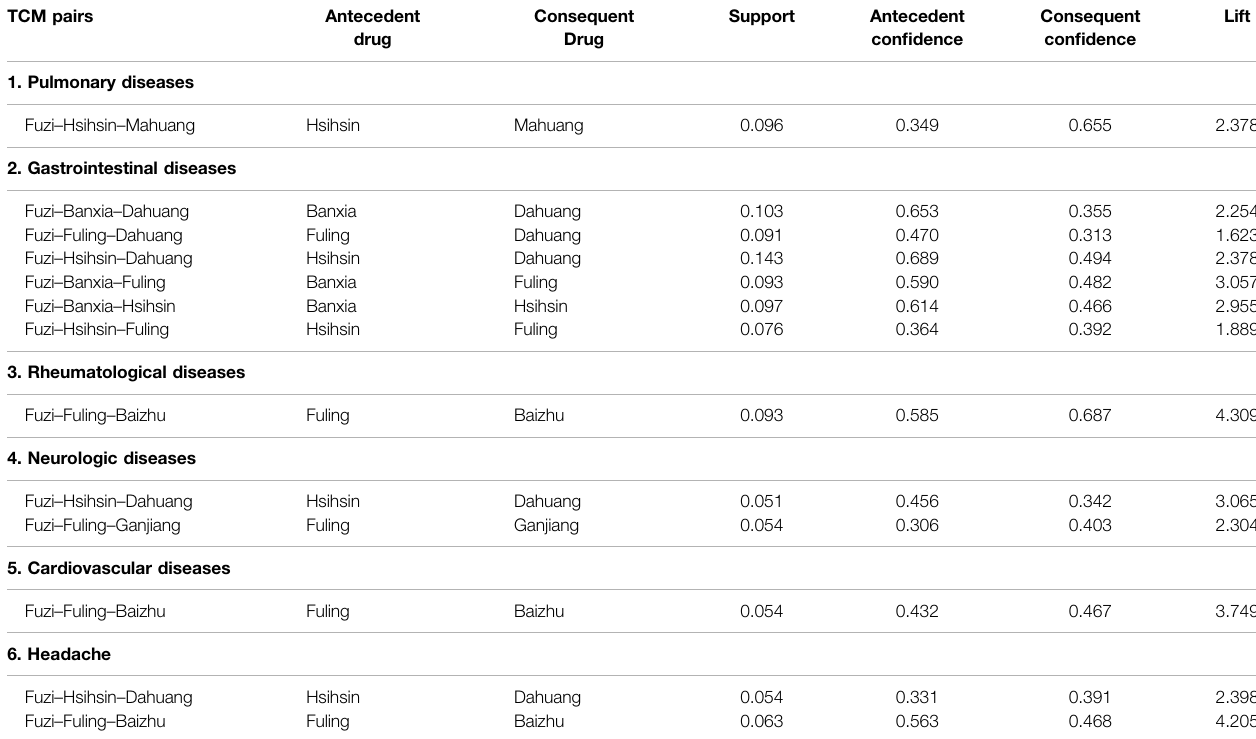
TABLE 5 | The combination principle of Fuzi and multiple TCM herbs discovered by market basket analysis for six clinical indications. TCM